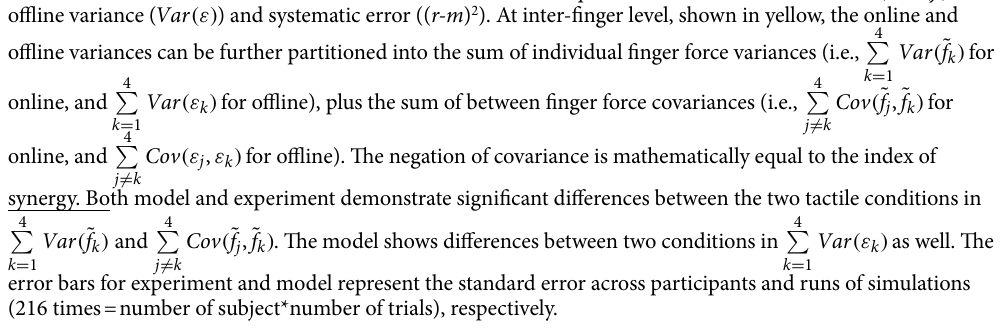
4 Var ( ˜ f k ) for k = 1 4 (cid:31) Cov ( ˜ f j , ˜ f k ) for j = k (cid:31) 4 Var (ε k ) as well. The k = 1 (cid:31)